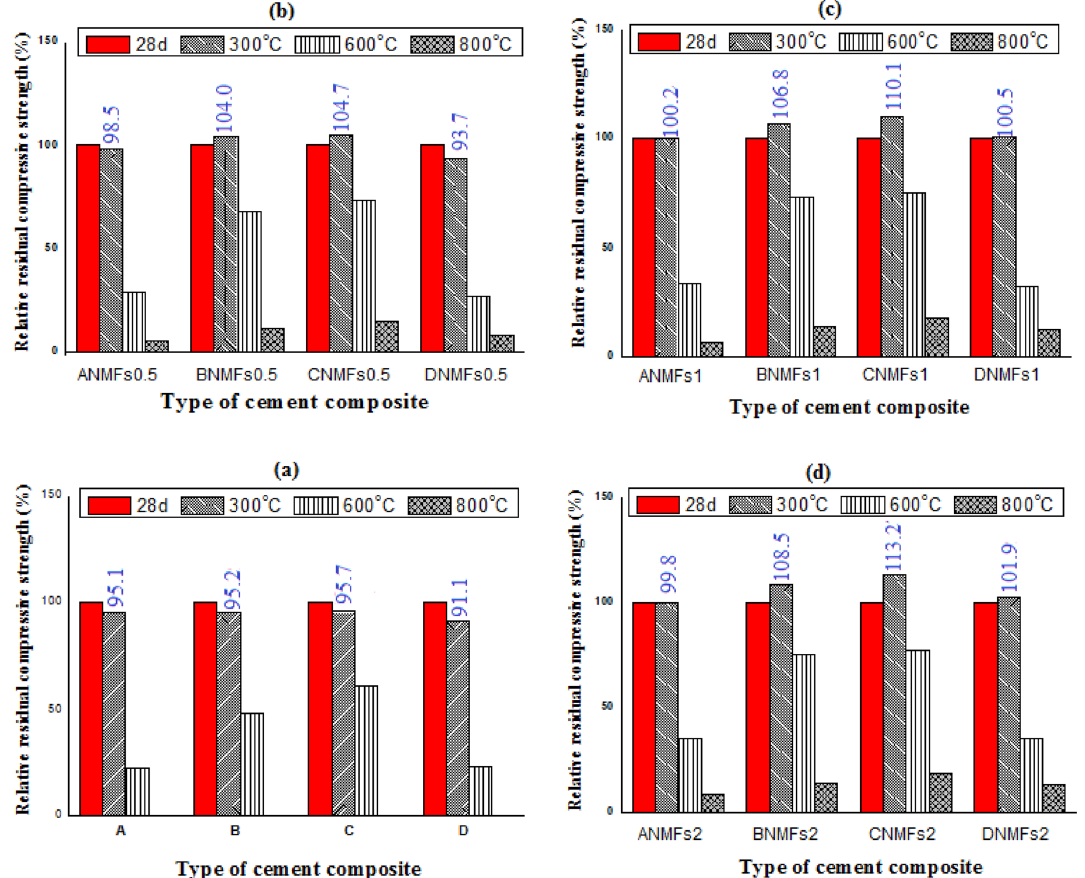
Figure 12. Relative residual compressive strength values for different fired cement composites after suddenly cooled.